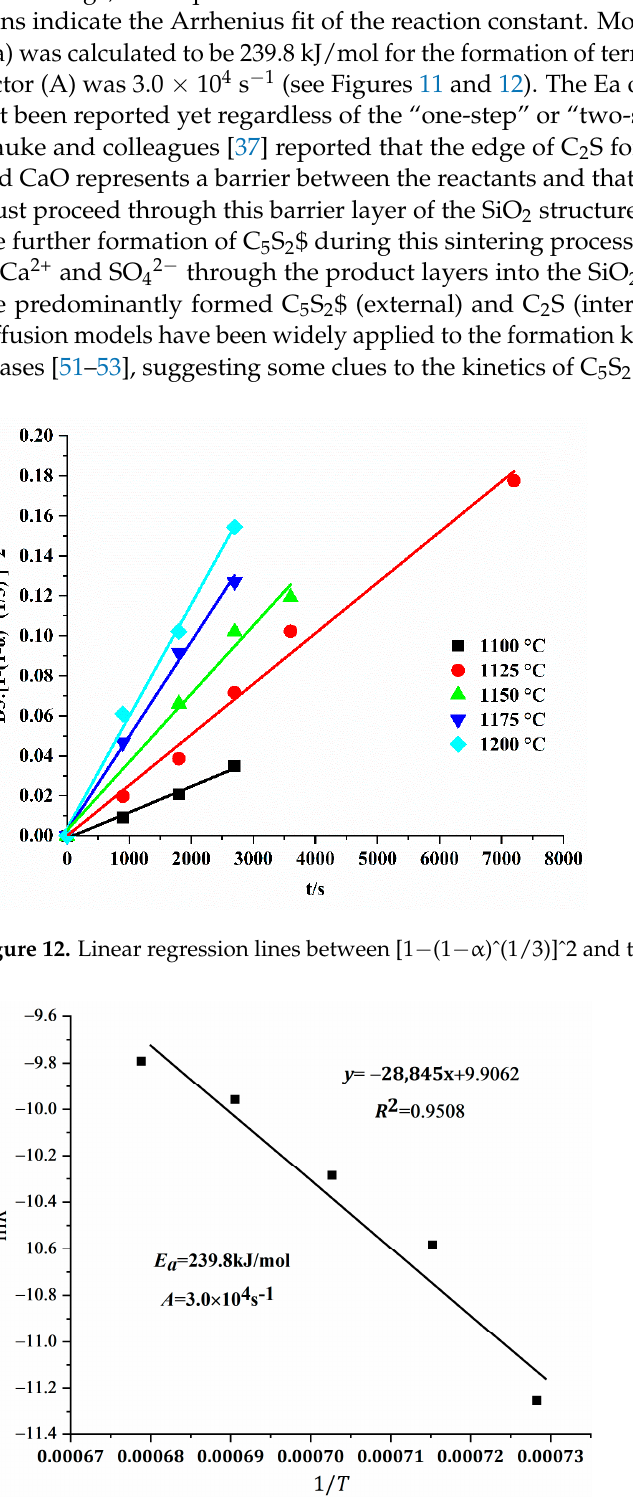
Figure 13. Regression lines between ln k and